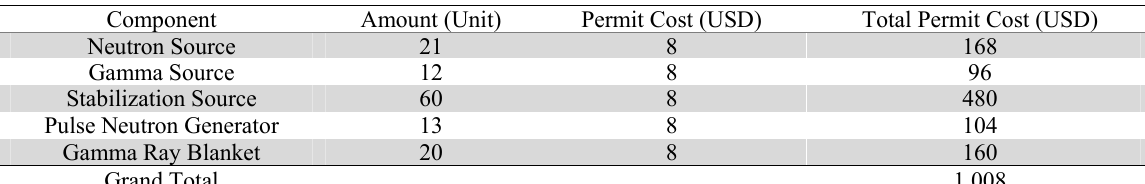
Annually Usage Permit Cost